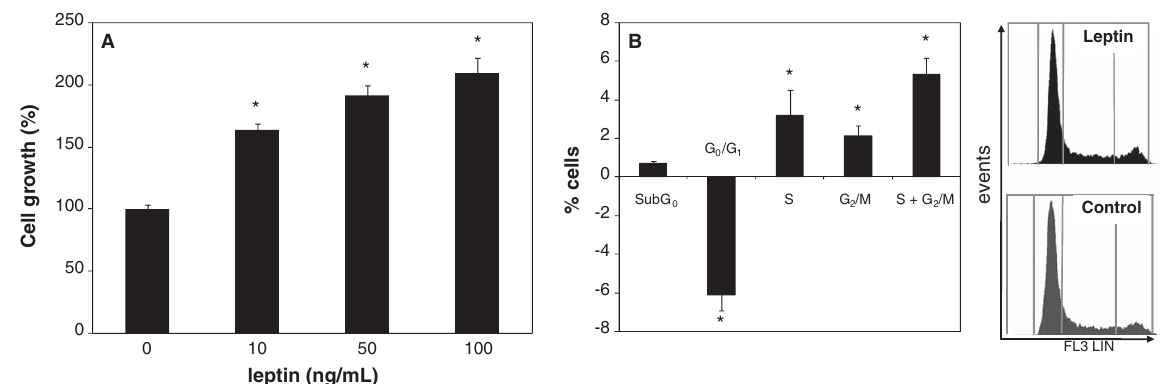
Fig. 1. Effects of leptin on cell proliferation and cell cycle. A) MCF-7 cells were exposed to 0, 10, 50 and 100ng/ml leptin for 48h and cell proliferationanalyzedbyMTTassayasdescribedinMaterialsandMethods.Resultsaremean ± s.e.mofthreeexperimentsandarenormalizedas percentage of the control value (0ng/ml leptin). B) Flow cytometry analysis of propidium iodide-stained MCF-7 cells with or without 50ng/ml leptin treatment for 48h. Bars represent the mean ± s.e.m. of the difference between leptin-treated vs. untreated control cells distributed on cell cycle phases and expressed as percentage of total viable cells. Representative histograms are shown (left panels). * p <0.05 Student’s t